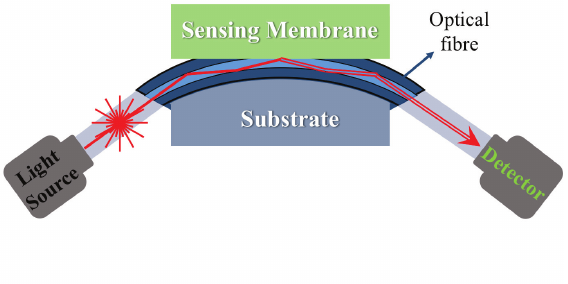
Figure 12. Schematic view of fiber-optic sensors. The probe light enters the optical fiber with initial wavelength λ 0 and is introduced on sensing material. The wavelength of light shifts under the influence of change in optical or optoelectronic properties of sensing film by